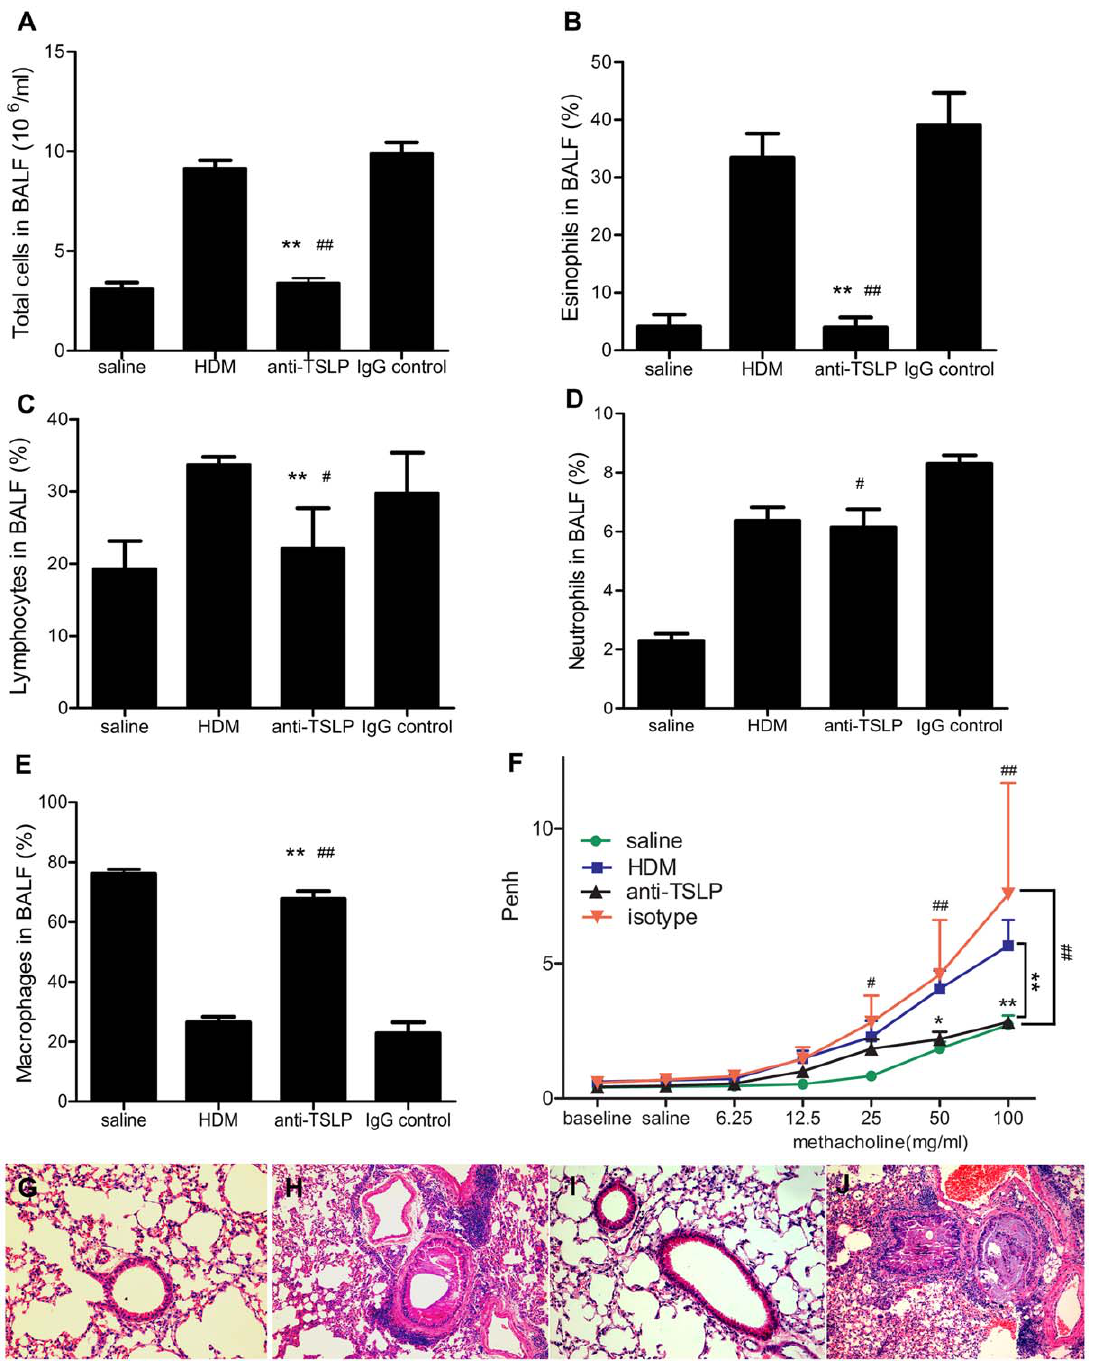
Figure 3. TSLP neutralization in the lung eliminates the airway inflammatory response and reduces methacholine-induced AHR. Number of total cells (A), eosinophils (B),lymphocytes(C),neutrophils (D) and macrophages (E) in the BALF revealed abundant inflammation in both the HDM-exposed mice and the IgG-treated controls, compared with the saline- and anti-TSLP-treated mice. The mice were intranasally administered HDM (5 days/week) for five consecutive weeks, and the airway inflammation was evaluated twenty-four hours following the AHR measurement. (F) Twenty-four hours after the final intranasal HDM or saline administration, the mice were stimulated with increasing doses of aerosolized methacholine (6.25, 12.5,25,50 and 100 mg/ml). AHR was measured using whole body plethysmography. (G-J) Representative photomicrographs of H&E-stained lung sections from mice that were exposed for 5 weeks to saline (G) or HDM (H) and pretreated with anti-TSLP mAb (I) or IgG isotype control (J) 60 minutes prior to and during the HDM exposure. Original magnification, 20 6 . The data shown represent the means 6 SEM (n=5). *p , 0.05 or **p , 0.01 compared with the HDM group, # p , 0.05 or ## p , 0.01 compared with the IgG-treated controls. The results are derived from 4 experimental groups (5 mice/per group) and the data are representative of 5 independent